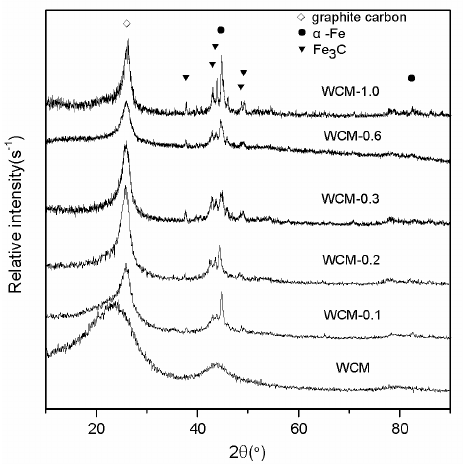
Figure 2. X-ray diffraction (XRD) patterns of α-Fe/Fe 3 C/woodceramic nanocomposites.